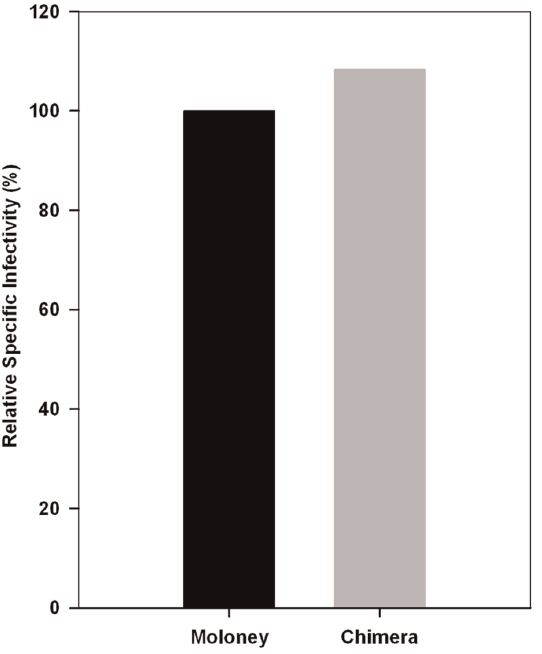
Figure 1. Specific infectivity of the viruses. 293T cells were transiently transfected with an infectious MoMLV or chimera proviral genome together with the reporter plasmid pBABE-Luc. 293T-mCAT1 cells were then infected with culture supernatants from the transfec- tants, and lysates of these cells were assayed for luciferase activity. Virions were assayed for RT activity following precipitation from the culture supernatants with polyethylene glycol. The graph shows the luciferase activity divided by the RT activity of the viruses, with the value for MoMLV set to 100%; thus the data represent the relative specific infectivities of the samples.